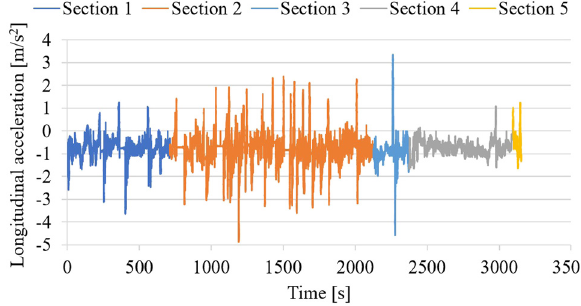
Figure 6: Velocity pro fi le on the Ch ȩ ciny – Kielce – Ch ȩ ciny route in the afternoon.